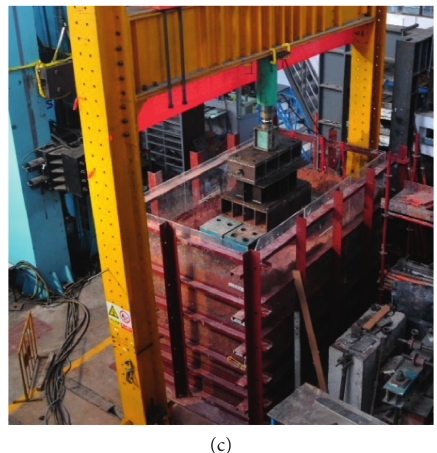
Figure 3: Test setup details (millimeters).